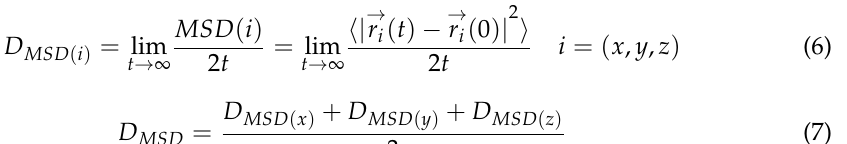
Figure 7. ∆ MSD in the x , y , and z directions of water in a nanochannel with different surface characteristics. According to the above result of the mean square displacement rate, using the varia- tion Form (6) of the Einstein relation, the self-diffusion coefficients ( D MSD ) of fluid water in the x , y and z directions in the four types of wall characteristic channels were calcu- lated respectively, and then the total average diffusion coefficient of fluid water in the nanochannels was calculated by Equation (7). The calculation results are shown in Table